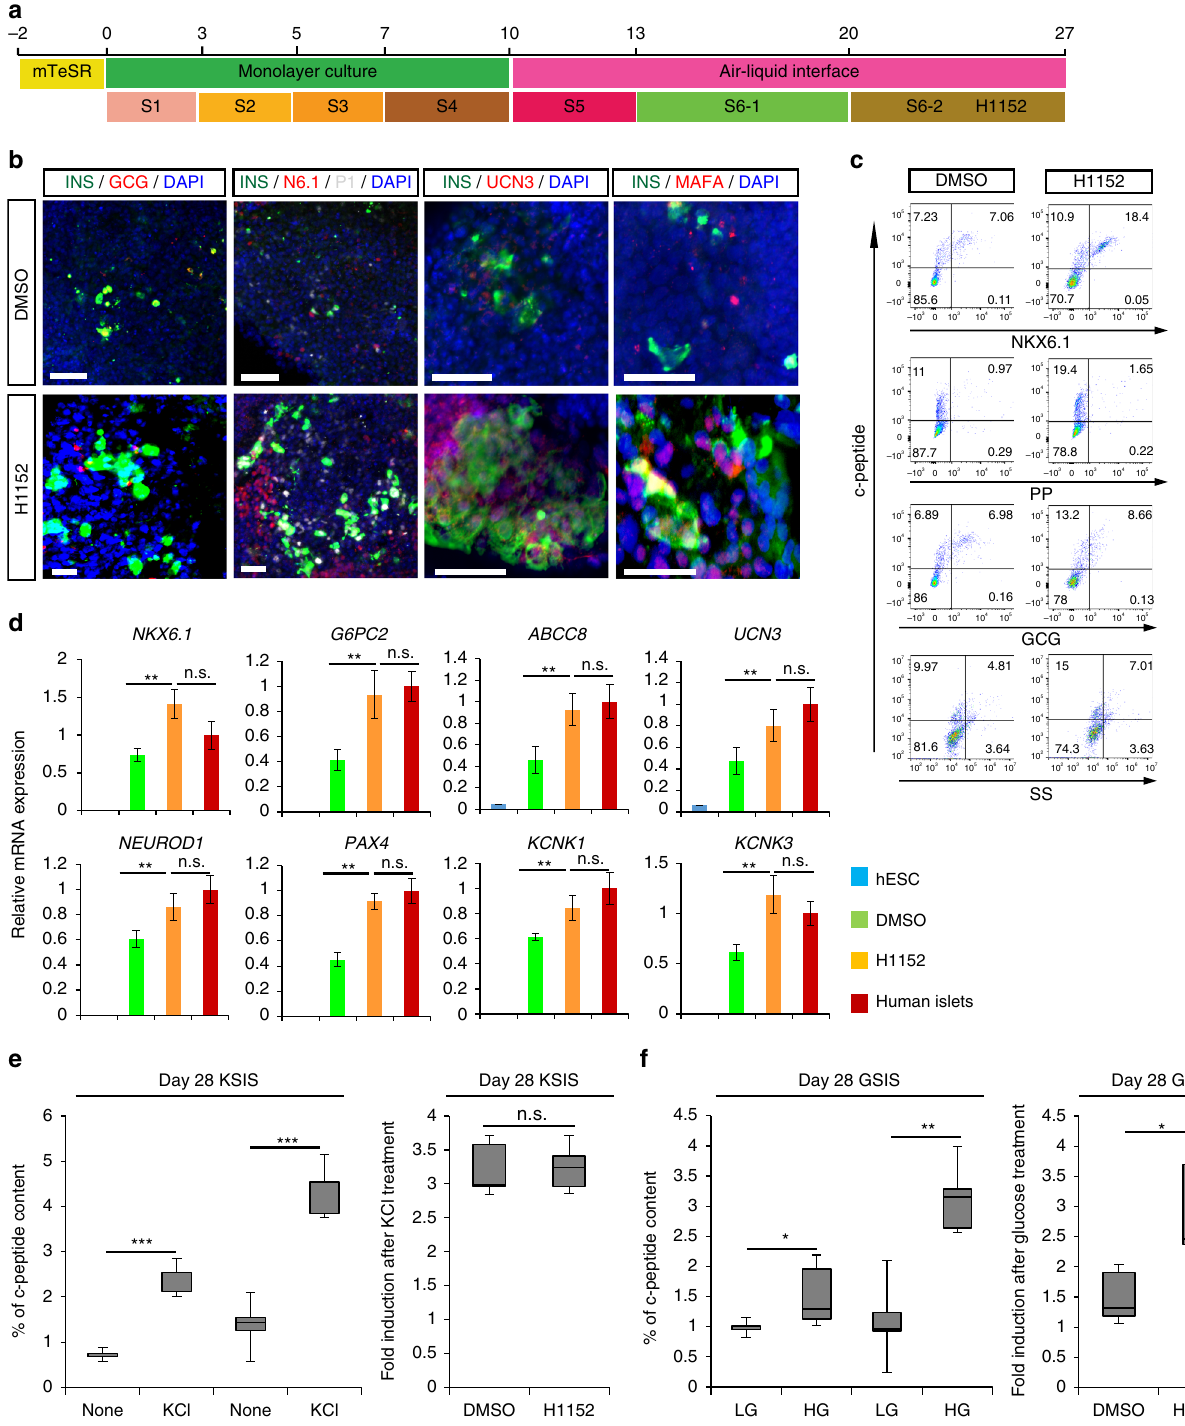
Fig. 4 H1152 promotes the generation and maturation of hESC-derived glucose-responding cells in the presence of a distinct protocol. a Scheme of the directed differentiation. b – d Confocal imaging ( b ) intracellular FCM ( c ) and qRT-PCR ( d ) analysis of H1152-treated or DMSO-treated cells. Scale bar : 100 µ m. N = 6 – 8 independent biological replicates. UCN3: Urocortin3, P1: PDX1, N6.1: NKX6.1, SS: somatostatin, PP: pancreatic polypeptide. Error bar is SEM. e The percentage of c-peptide content and fold induction of H1152-treated or DMSO-treated cells after exposure to 30 mM KCl. Fold induction was